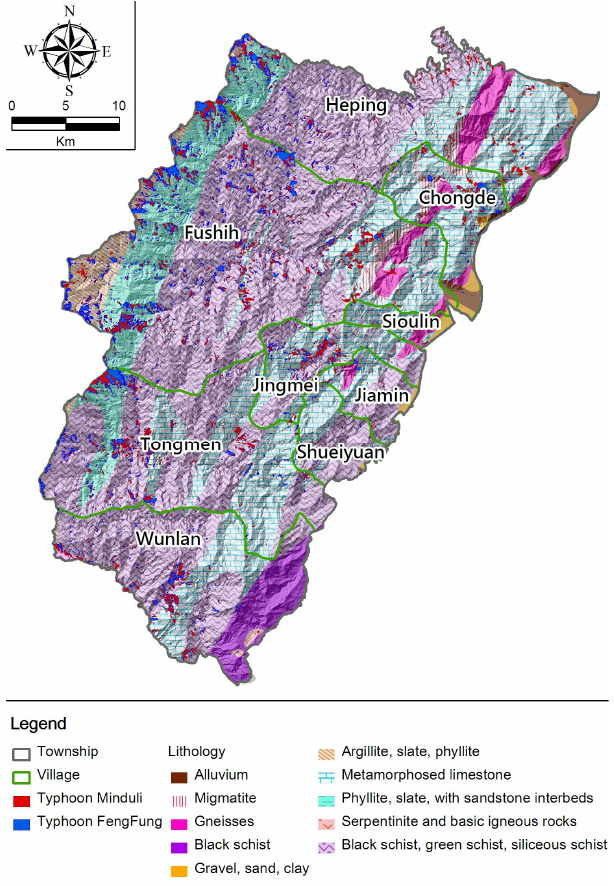
Fig. 4. Inventory map of a shallow landslide triggered by two ty- Figure 4. Inventory map of shallow landslide triggered by two typhoon events and geological 603 phoon events and geological map of study area.